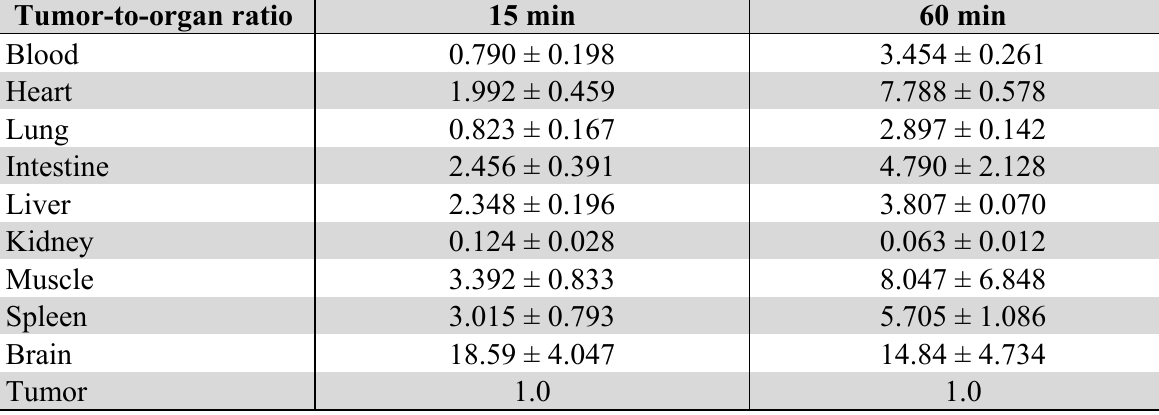
Table 2. Tumor-to-organ ratios of 111 In-DOTA-Lys-DUP-1 in mice carrying PC-3 tumors. Tumor-to-organ